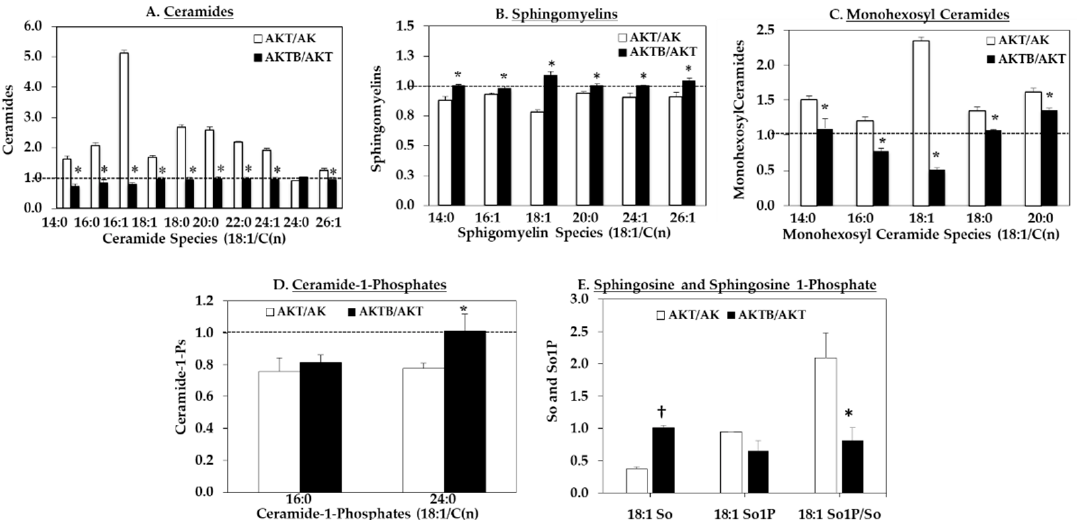
Figure 6. Effects of iPLA 2 β inhibition on sphingolipid abundances in Akita β -cells ± ER stress. Lipids were extracted from Akita β -cells treated with thapsigargin (T, 1 µ M for 8 h) in the absence and presence of S -BEL (10 µ M). The ratio of sphingolipids ± T (AKT/AT) and T ± S -BEL (AKTB/AKT) are presented as mean ± SEM pmols lipid/nmol total sphingolipid: ( A ) Ceramide pool; ( B ) Sphingomyelin pool; ( C ) Monohexosyl ceramide pool; ( D ) Ceramide-1-phosphate pool; and ( E ) Sphingosine (So) and So1P. Two-Way ANOVA was utilized for statistical analysis. (* ,† Significantly different from AKT/AK; p < 0.05 and p < 0.0005, n = 3 per group.).